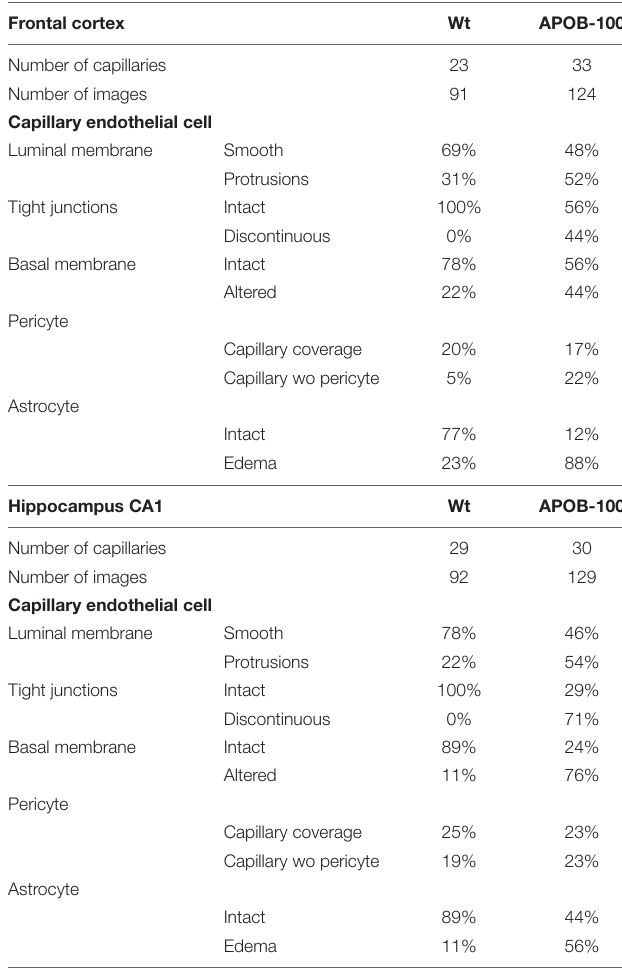
Values are shown as percent of all images analyzed in the group. Pericyte coverage was calculated as written in the Materials and methods